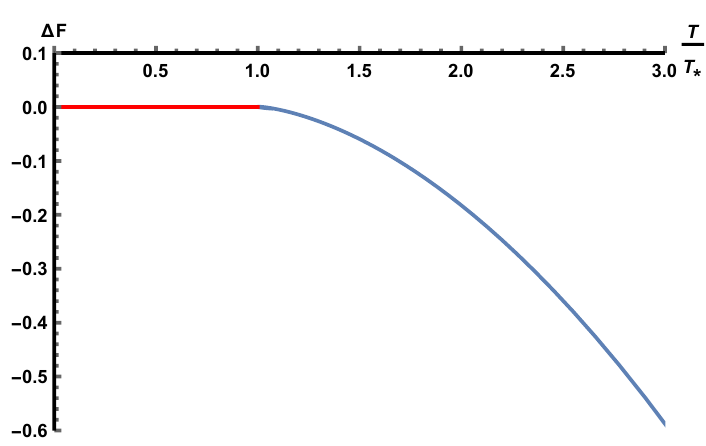
Figure 1 . The free energy di(cid:11)erence of the quenched dynamical holographic QCD model as a function of T=T (cid:3) . The parameters (cid:22) G = 0 : 75GeV and G 5 = 1 : 25 are used and the critical temperature is T (cid:3) =